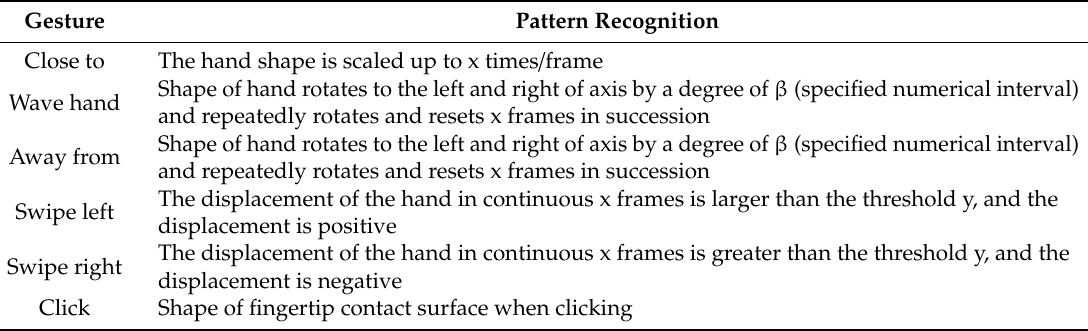
Table 2. Define gesture based on pattern recognition and pressure